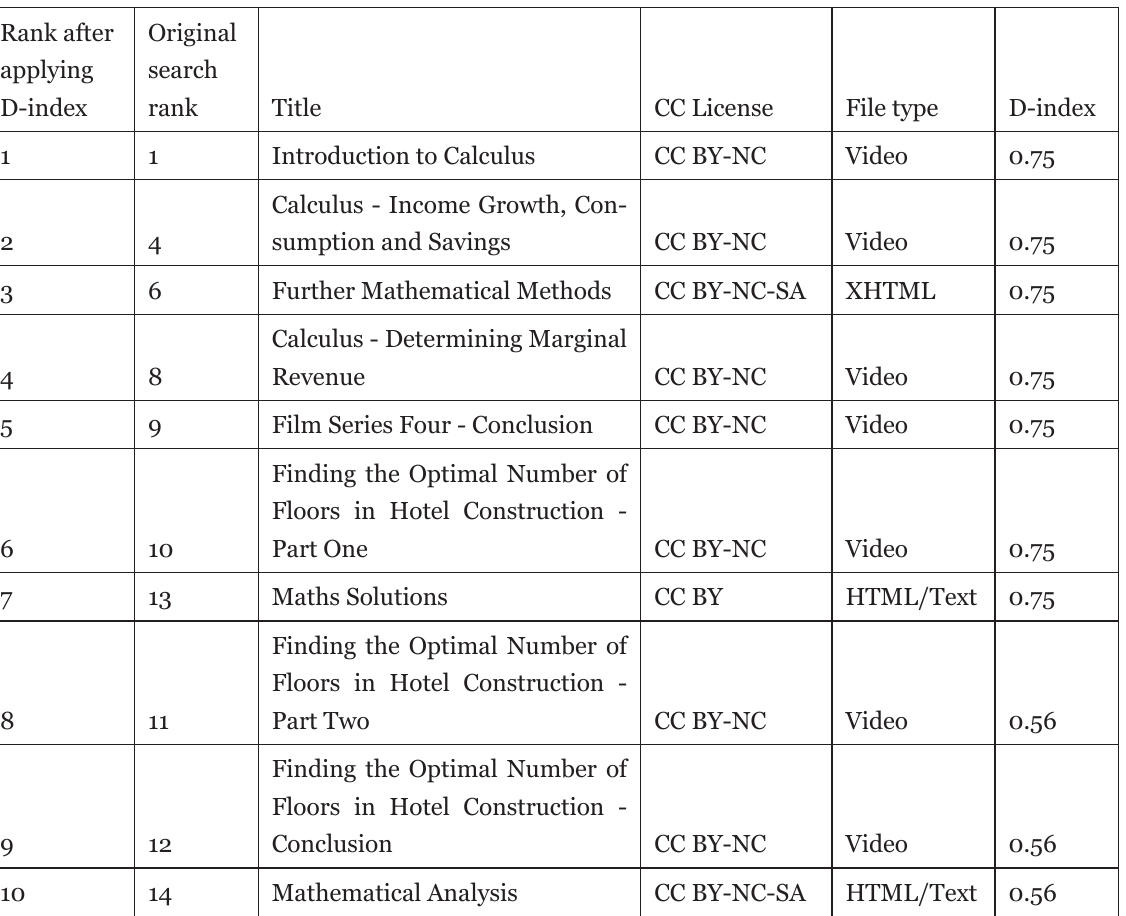
Top Ten Results when D-index is Applied to the Results Returned by JORUM Rank